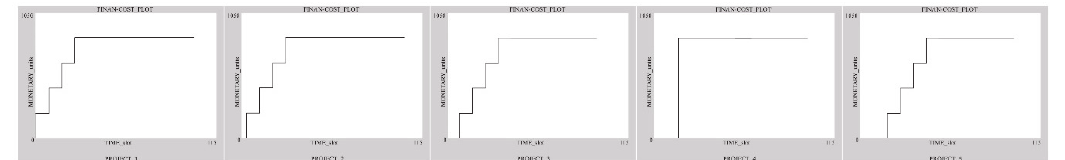
Fig. 7. Funding curves defined in the second experiment. Project 4 is given a high funding to ac- celerate its schedule